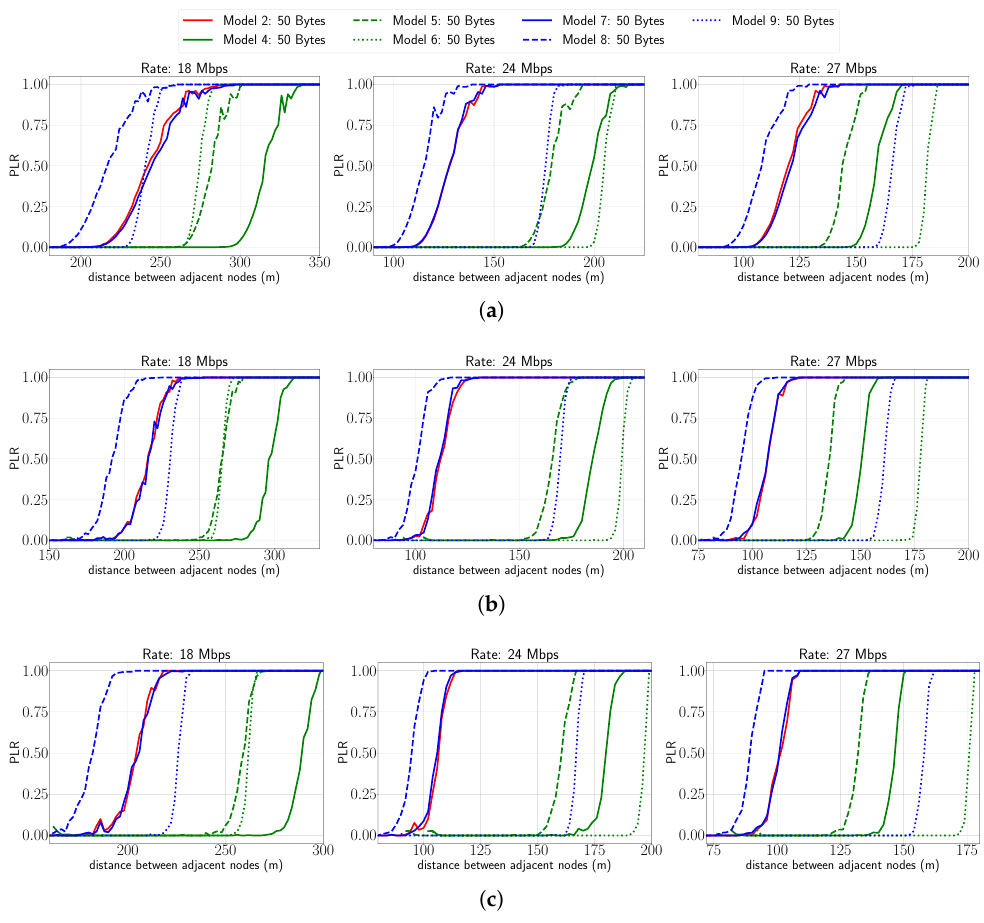
Figure 7. PLR vs. distance for different rates and for different linear chain topologies. Approximation of theoretical models with packet size of 50 bytes. ( a ) Number of nodes: 2, ( b ) number of nodes: 3, ( c ) number of nodes: